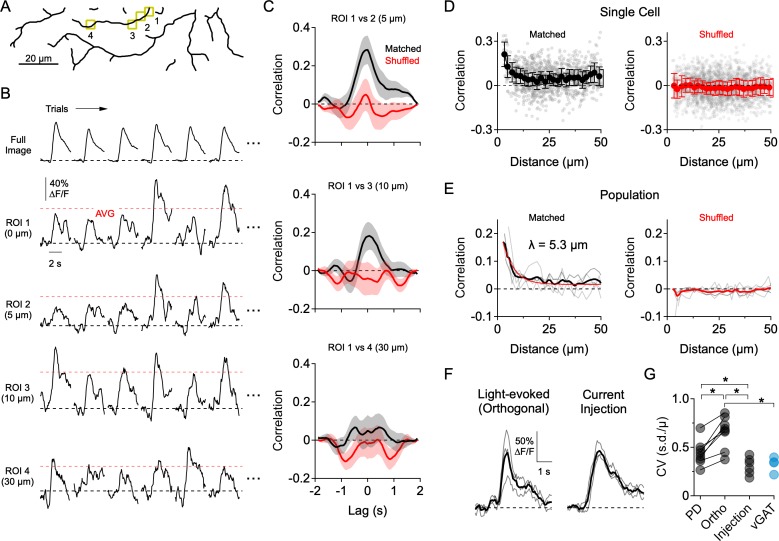
Dendritic Ca2+ signals form independently over small dendritic regions.(A) Reconstruction of the imaging area in the ON arbor of an ON-OFF DSGC. (B) Ca2+ signals over 30 consecutive trials in response to motion in a direction orthogonal to the preferred-null axis (only six trials are shown). Ca2+ signals were extracted from the ROIs highlighted in A, or from the entire arbor within the imaging window (Full Image). Red dotted lines indicate the average peak Ca2+ signal over all trials. (C) Cross-correlation of the mean-subtracted residual Ca2+ signals between ROI one and the other highlighted ROIs, each of which is at an increased distance away. Correlations were performed using matched trials (black) or shuffled trials (red). (D) Peak correlation versus distance between the ROIs for matched (black) and shuffled trials (red) in a single DSGC. Faded data points are individual correlation values, solid points are the average (± s.e.m.) over 2 µm bins. (E) Peak correlation versus distance for a population of 7 ON-OFF DSGCs for matched and shuffled trials. Faded lines are the average correlation versus distance data for single cells, bold lines are the population average. For matched trials, the thin red line is an exponential fit, with a space constant of λ = 5.3 µm. (F) Light-evoked Ca2+ signals from an example ROI in response to orthogonal motion compared to amplitude-matched Ca2+ signals evoked by current injection at the soma (measured in synaptic blockers: 50 µM DL-AP4, 20 µM CNQX, 10 µM UBP-310). Thin lines are individual trials; thick lines are the average. (G) Coefficient of variance (standard deviation divided by the mean) for the peak Ca2+ signals evoked by preferred motion, orthogonal motion, somatic current injection, and in response to motion in a mouse that has the vesicular GABA transporter knocked out of SACs (Slc32a1fl/fl::ChatCre; vGAT KO). Asterisks indicate p<0.05, t-test.Figure 3—source data 1.Calcium responses, cross-correlation, and variability measurements.